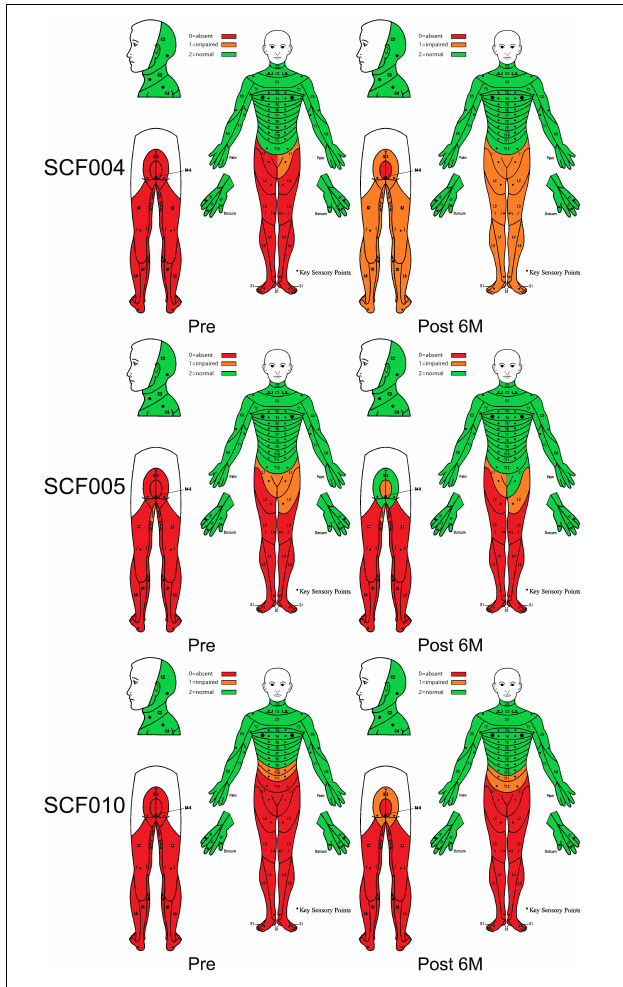
FIGURE 5 | Dermatomal sensory scores according to the International Standards for Neurological Classification of Spinal Cord Injury before and at 6 months after the